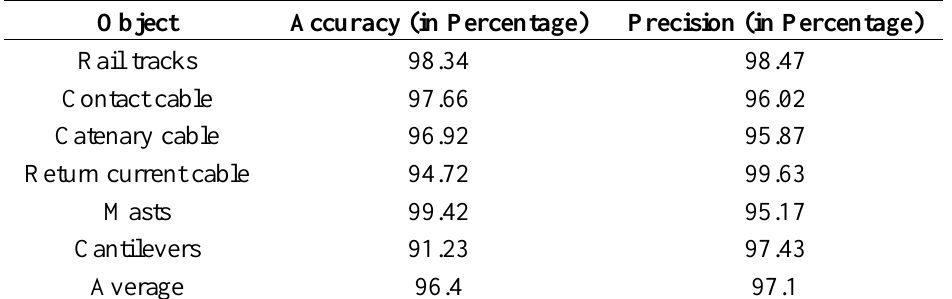
Table 4. Results at point cloud level in terms of recognition accuracy and precision.